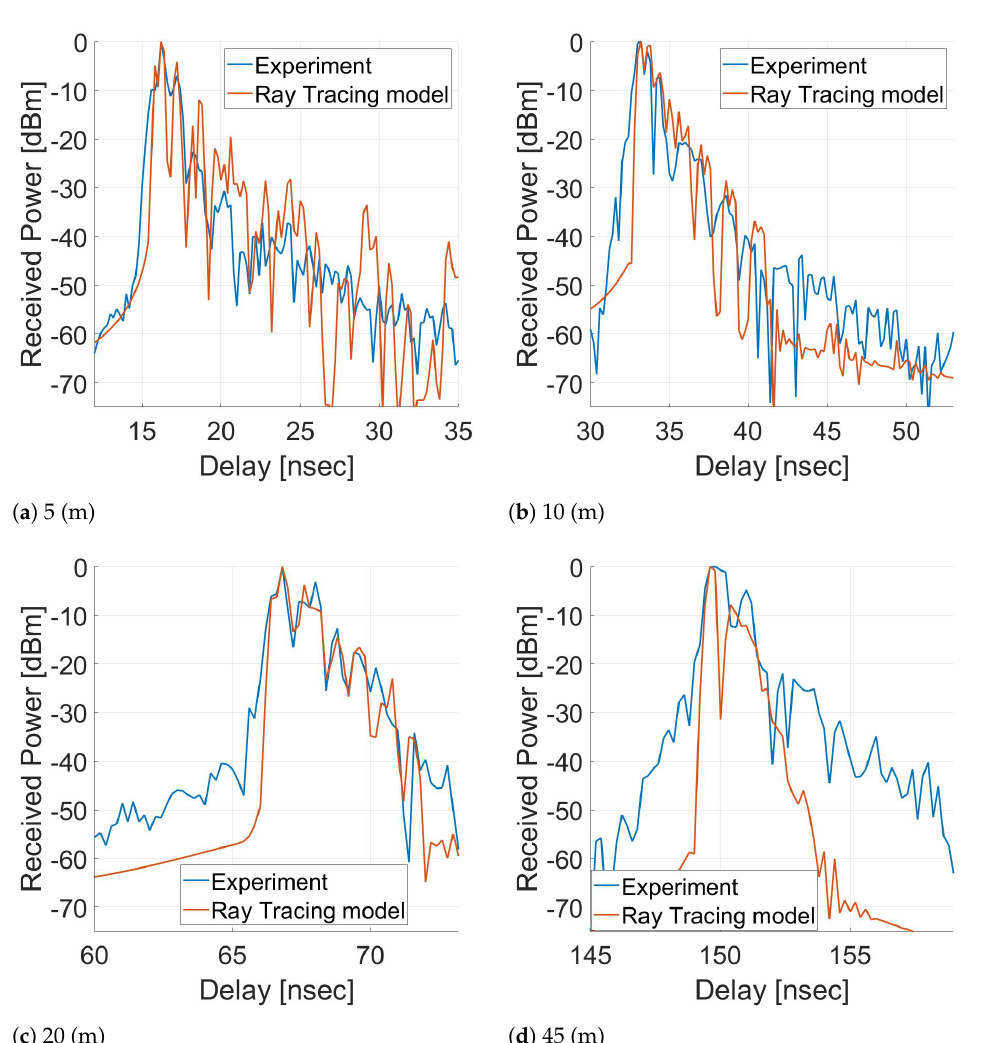
Figure 8. The time domain response of the transmission scattering parameter S 21 for various